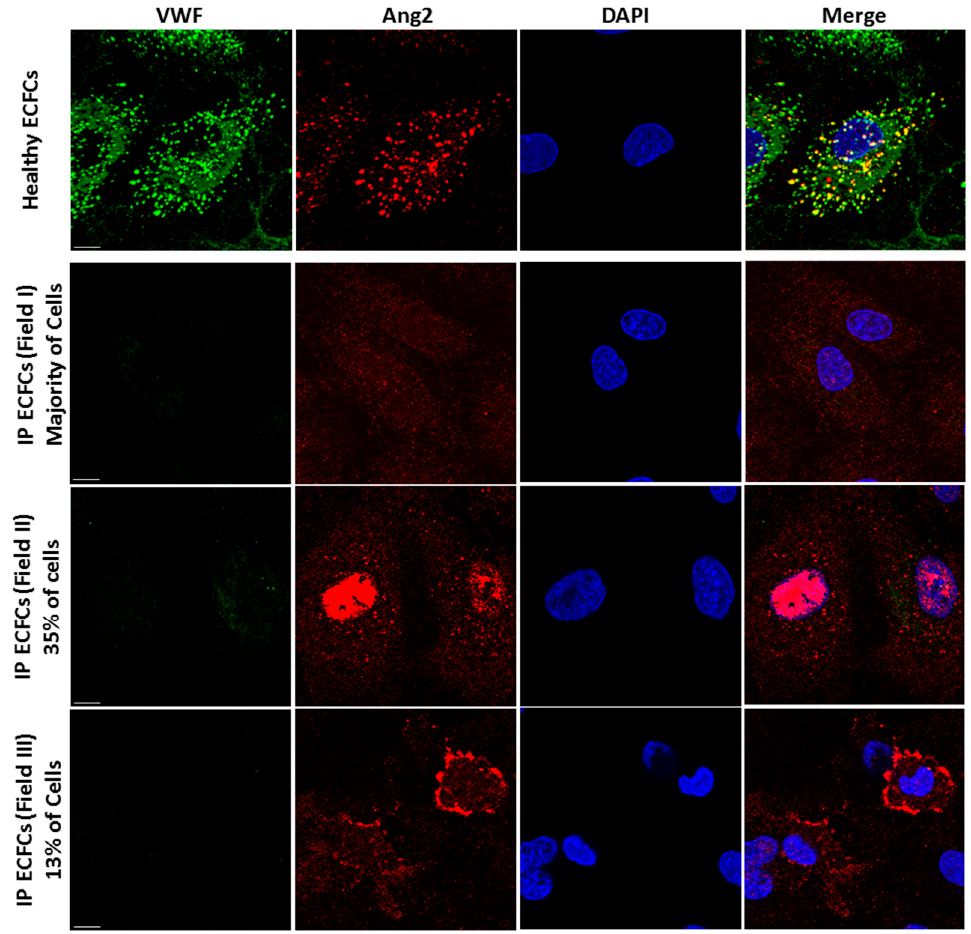
Figure 4. Altered trafficking of angiopoietin-2 (Ang2), the inflammatory cargo of Weibel–Palade bodies (WPBs), in index patient (IP) endothelial colony-forming cells (ECFCs) . Storage of VWF (green) and Ang2 (red) in WPBs is visualized by immunofluorescence staining and subsequent microscopy analysis (by Zeiss Apotome.2 microscopy) of normal ECFCs (upper section). The merge of green and red channels displays the colocalization of VWF with Ang2 in healthy ECFCs. In the IP ECFCs, in absence of VWF and WPBs, the storage of Ang2 is changed. In the majority of IP ECFCs, the Ang2 is spread throughout the cytoplasm (the second row of images); in about 35% of IP cells, the Ang2 is accumulated nearby the nucleus (third row); and in about 13% of IP cells, the Ang2 signals are enriched at the cell periphery (lower row images). Scale bars, 10 µ